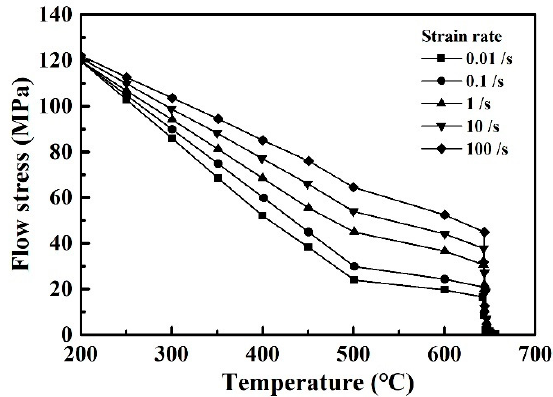
Figure 2. Flow stress of Al3003 aluminum alloy.